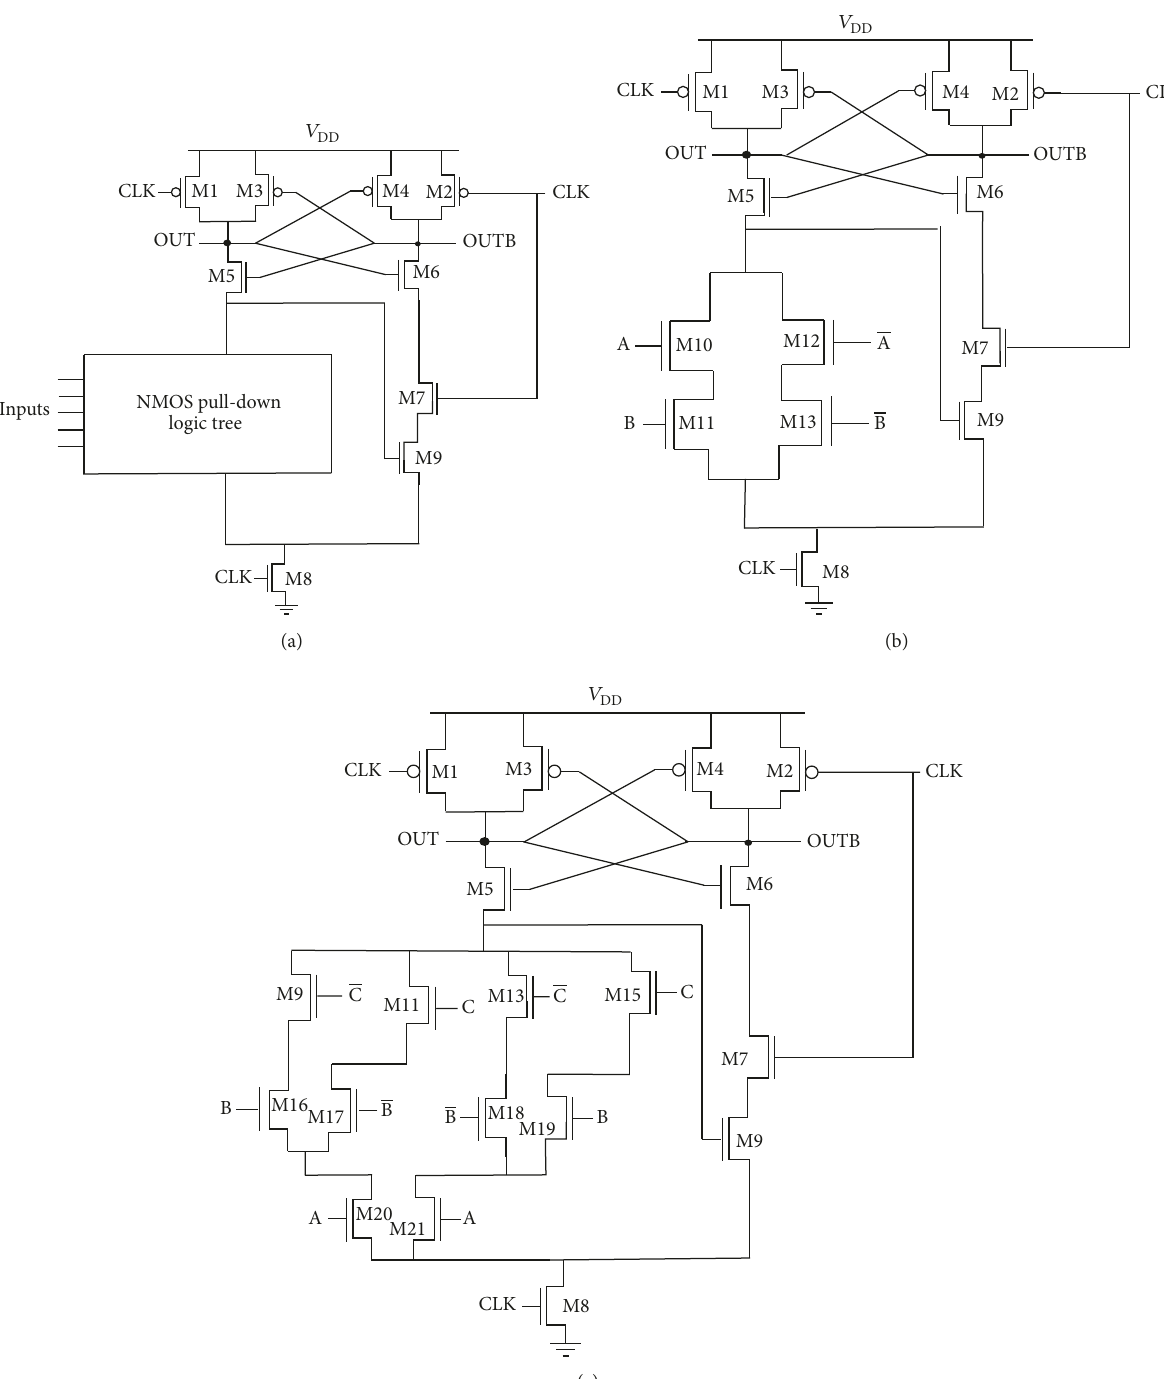
Figure 2: (a) Generic architecture of EDCVSL circuit: (b) two-input and (c) three-input EDCVSL XOR-XNOR gate.